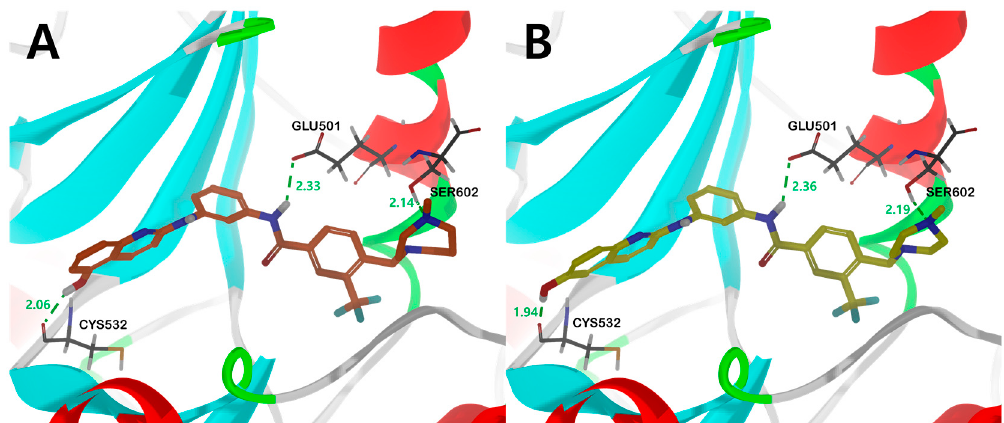
Figure 6. The binding mode of compound ( A ) 17b and ( B ) 18a in the catalytic kinase domain of B-RAF V600E model. For clarity purposes, only key residues having interactions were shown. Compounds 17b and 18a are shown in orange and yellow colored stick models, respectively. Fundamental hydrogen bonding interactions are shown in green dashes. The number near the dashes indicates the bonding distance in units of Å.